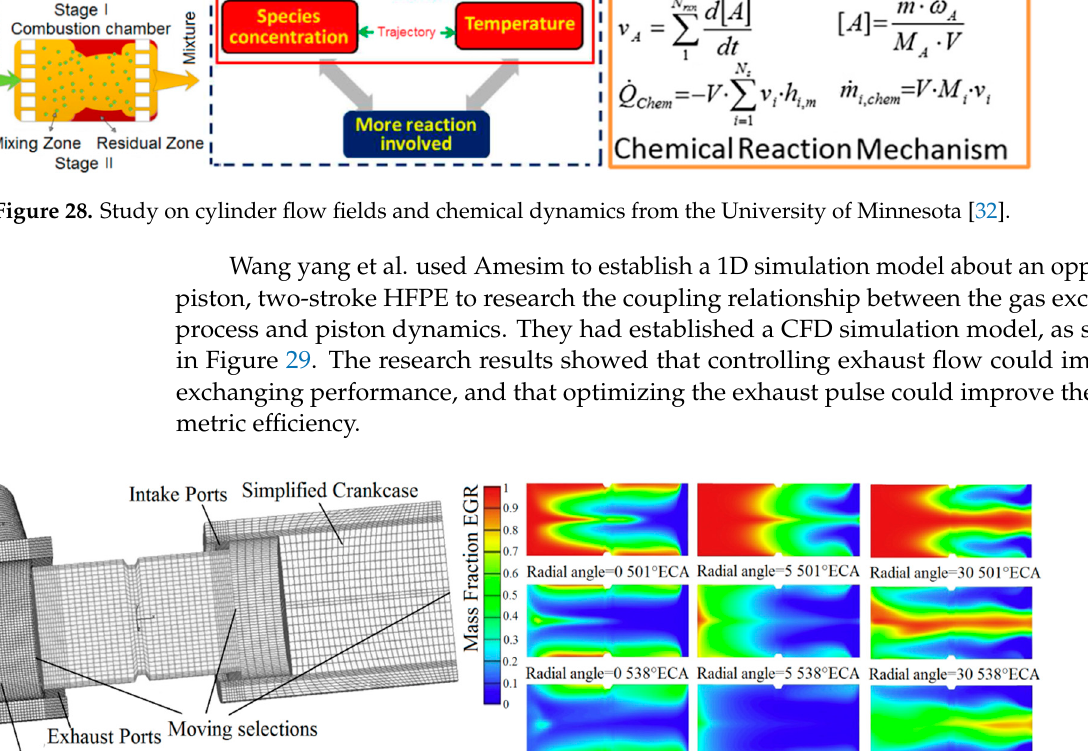
Figure 28. Study on cylinder flow fields and chemical dynamics from the University of Minnesota [32].